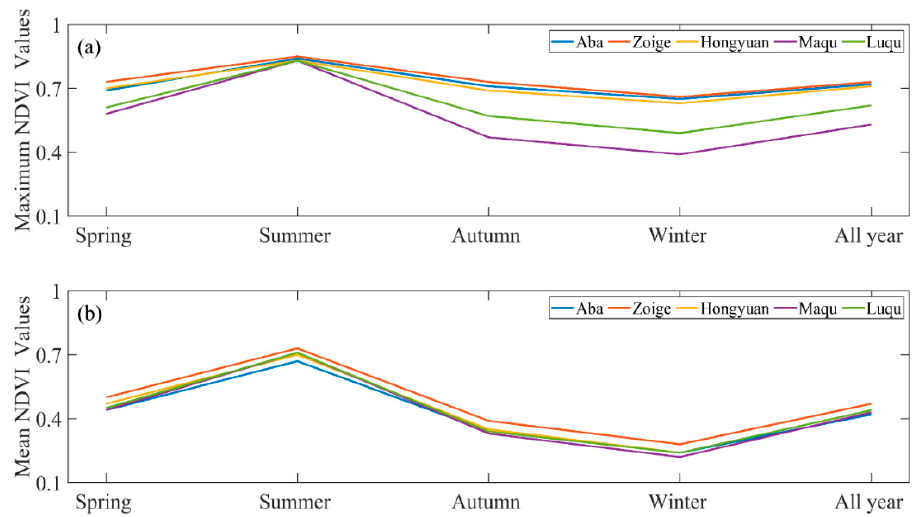
Figure 7. Trends of the maximum and mean values of the NDVI values in different districts and counties of the RWA. Note: ( a , b ) indicate the maximum and mean NDVI values, respectively.